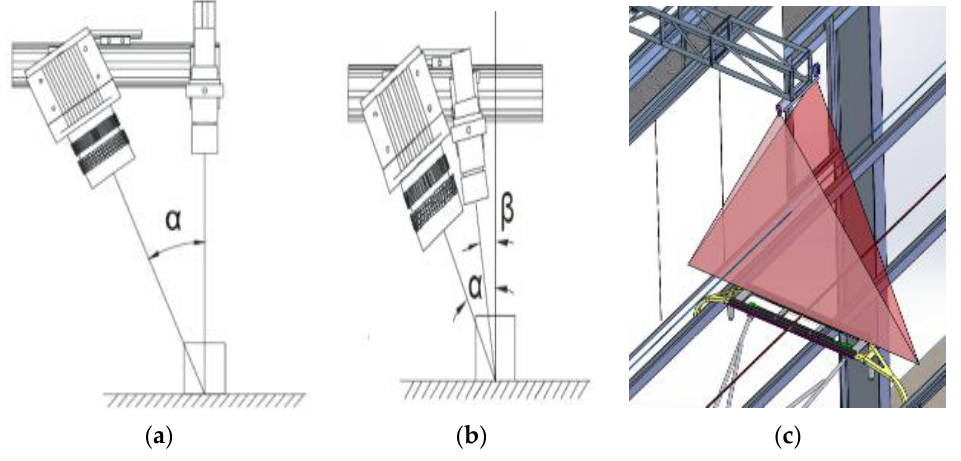
Figure 6. ( a ) System Layout 1; ( b ) System Layout 2; ( c ) The Mechanical Drawing Diagram.